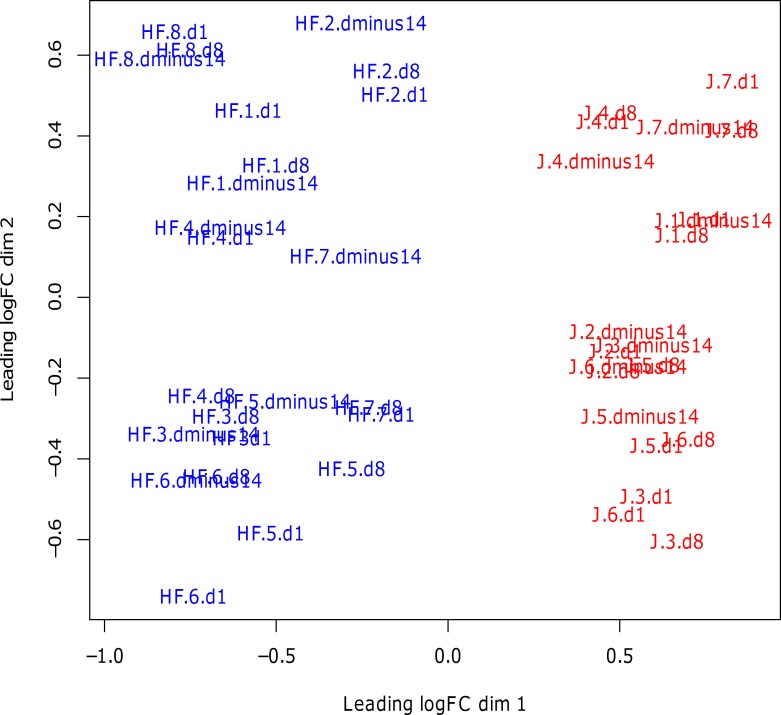
Multidimensional scaling plot which shows the measured similarity of the samples in 2-dimensions.The first letters represents the breed of each calf (HF = Holstein-Friesian, J = Jersey), the following number represents the ID number (1–8 for Holstein-Friesian and 1–7 for Jersey) and the final text and numbers represents the time-point relative to weaning (dminus14 = day -14, d1 = day 1, d8 = day 8). The samples labelled in blue are Holstein-Friesian and the samples labelled in red are Jersey.